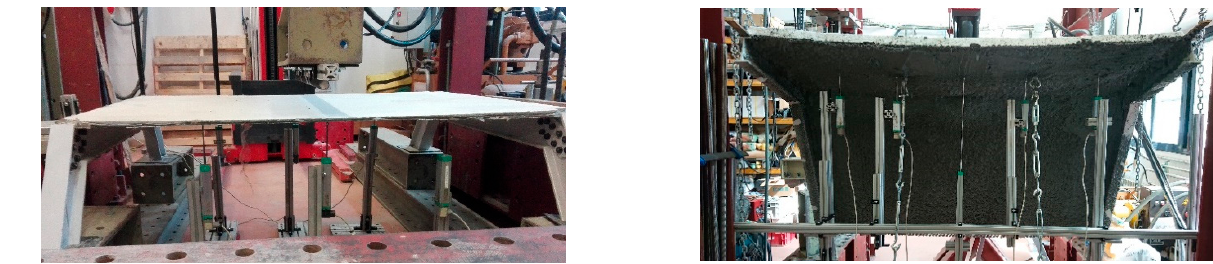
Figure 3. Specimens HP1 ( left ) and HP2 ( right ) before